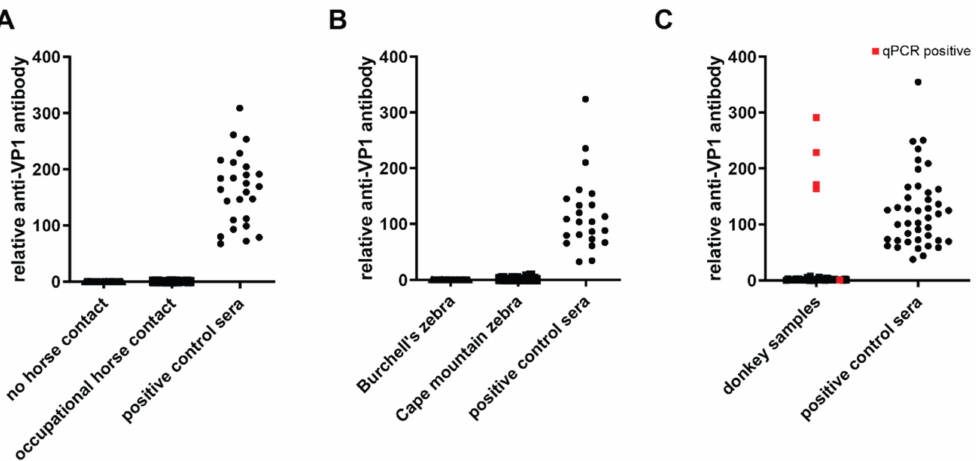
Figure 4. Detection of EqPV-H DNA and VP1 antibodies in serum samples from different species. qPCR and LIPS for EqPV-H were performed on serum samples of different species. Previously positive tested serum was used as positive control in LIPS assay. ( A ) Human sera were tested for the presence of anti-VP1 antibodies by LIPS. Study cohort was divided between people with or without horse contact as previously shown [11]. ( B ) Sera of two different zebra species were tested for the presence of anti-VP1 antibodies by LIPS. ( C ) Donkey serum samples (from Germany, Italy, and Bulgaria) were tested for the presence of EqPV-H DNA by qPCR and presence of anti-VP1 antibodies by LIPS. qPCR positive samples are colored in